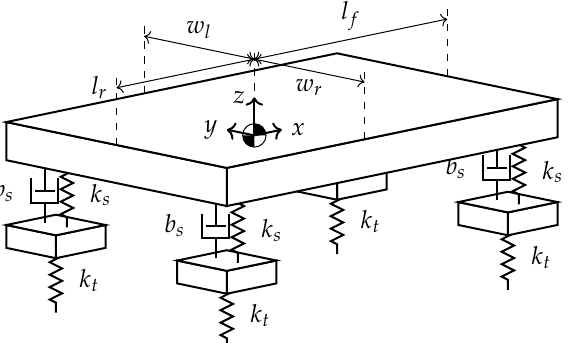
Figure 1. Fourteen degrees of freedom vehicle model. The x , y , and z axes indicate, respectively, the longitudinal, lateral, and vertical directions of the vehicle. Parameters k s , b s , and k t denote the suspension stiffness, damping, and the tire